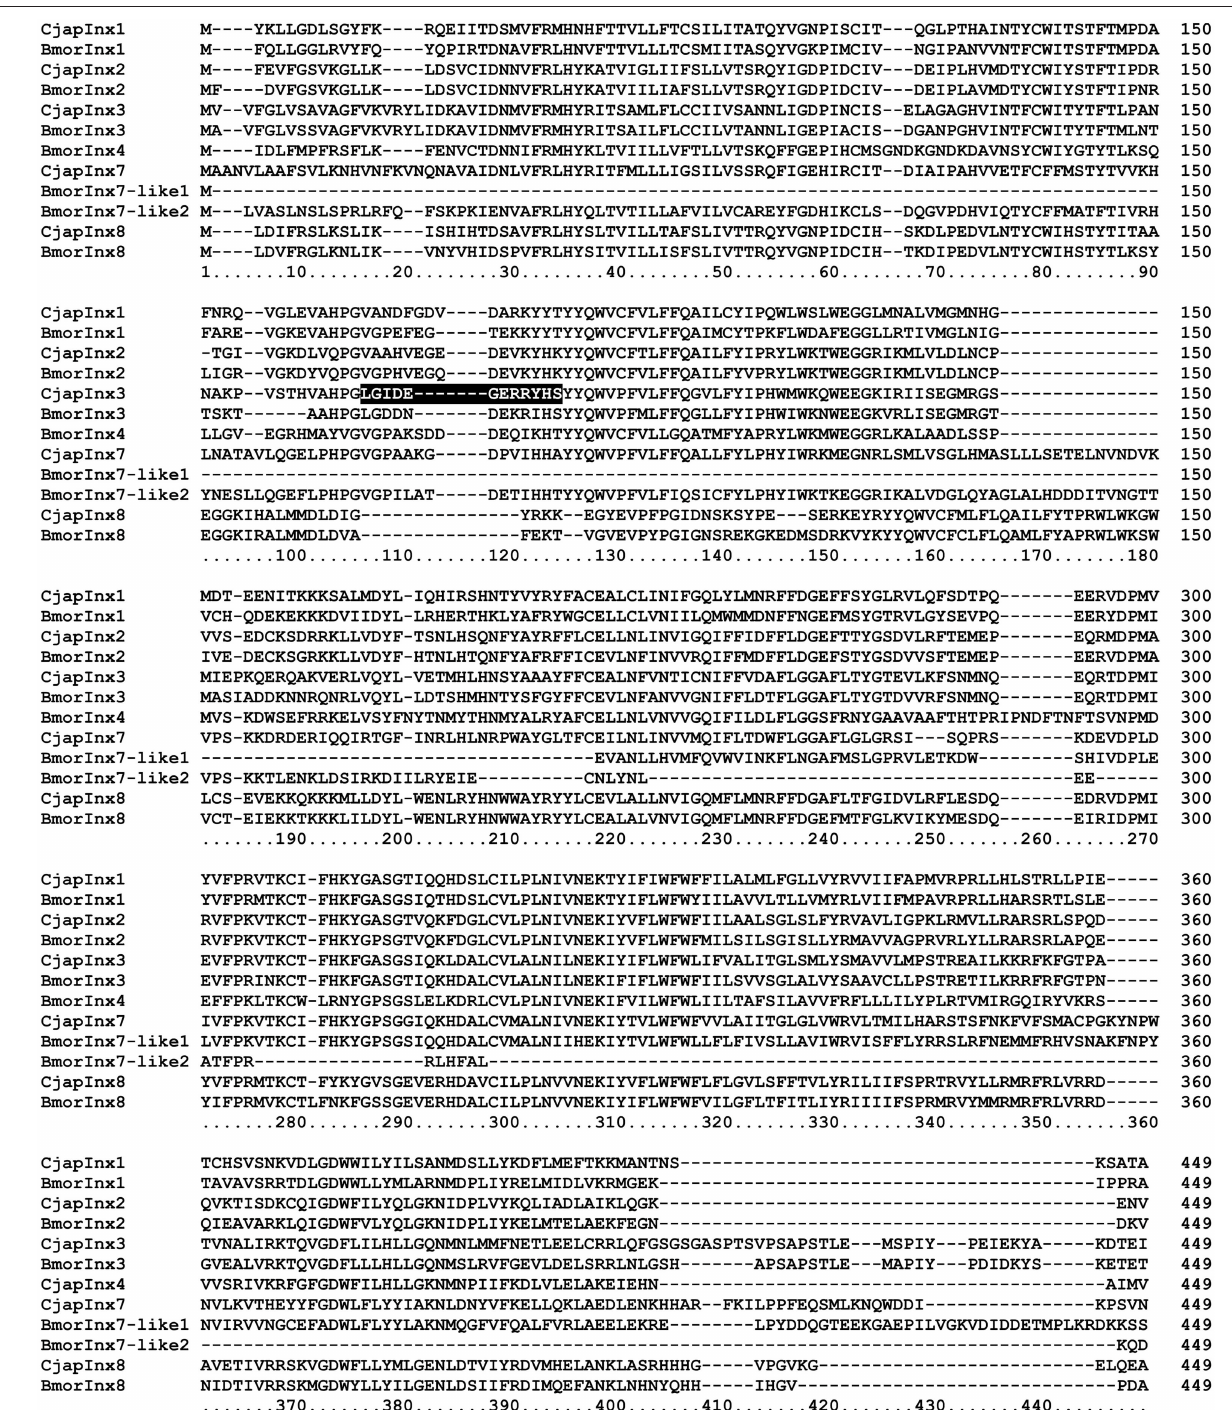
FIGURE 4 | Amino acid sequence alignment of innexin molecules expressing in the antenna of Camponotus japonicus . Subtypes of innexin expressing in C. japonicus antennae (CjapInx1, CjapInx2, CjapInx3, CjapInx7, CjapInx8) are compared with each other and with Bombyx innexins in amino acid sequence. A sequence used as an epitope for immunohistostaining is